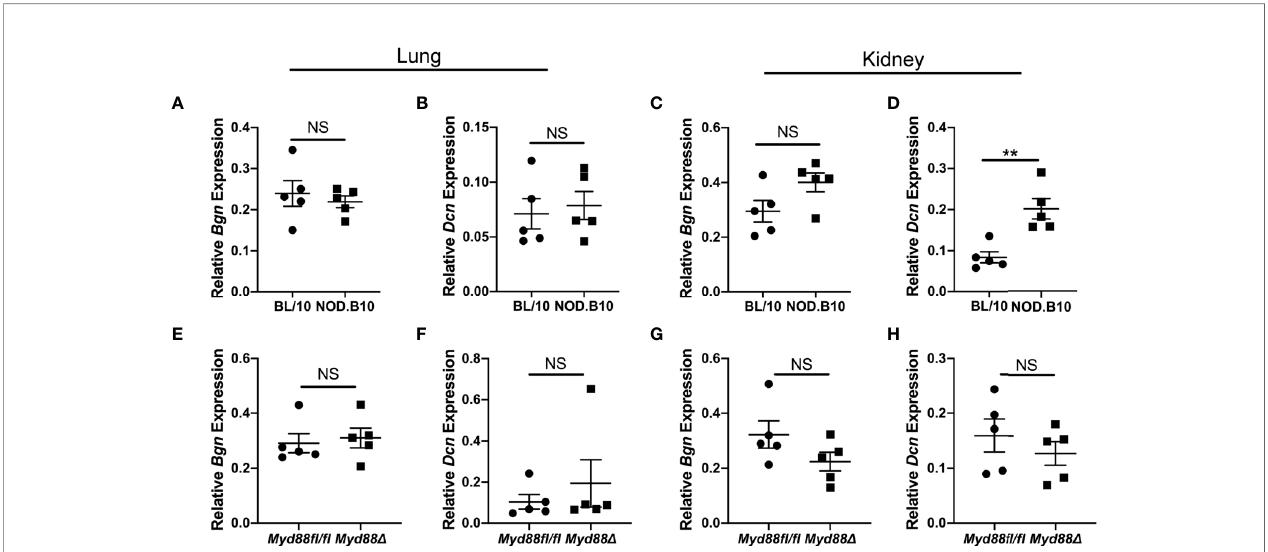
FIGURE 3 | Dcn is elevated in the kidneys of pSS mice. Expression of Bgn and Dcn was determined in lung and kidney tissue from (A – D) BL/10 and NOD.B10 mice (n = 5 each) and from (E – H) NOD.B10 Myd88 fl / fl and NOD.B10 Myd88 D mice (n = 5 each) by qPCR. Expression was normalized to b -Actin . Horizontal lines represent the mean and SEM, (NS, non-signi fi cant; **p <